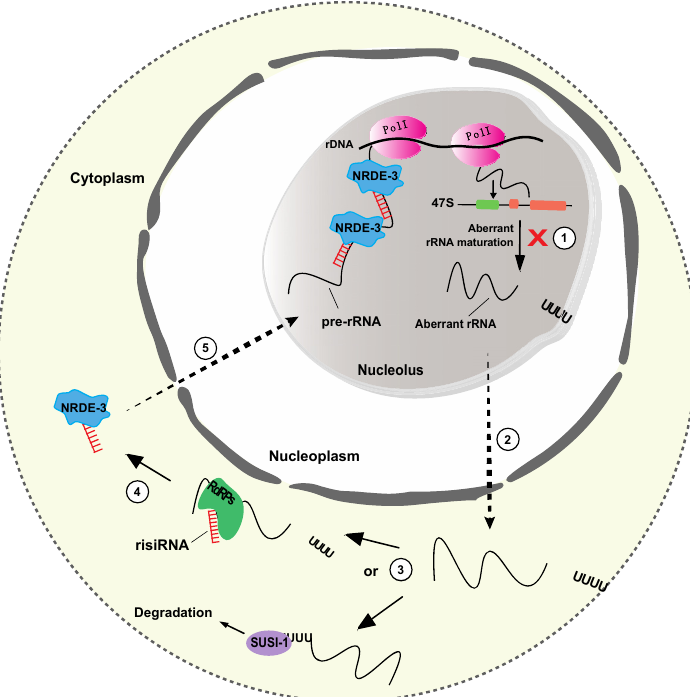
Figure 5. Biogenesis and function of risiRNAs in C. elegans . ( 1 ) In response to cellular stress or deficient rRNA modification processing, aberrant rRNAs accumulate and are uridylated at their 3 ′ end. ( 2 ) The uridylated rRNAs are, then, transferred to the cytoplasm, where they are either degraded by 3 ′ -5 ′ exoribonuclease SUSI-1 ( 3 ), or, transcribed by RNA dependent RNA polymerases (RdRPs) to produce risiRNAs (antisense ribosomal siRNAs) ( 4 ). risiRNAs can then interact with Argonaute proteins, like NRDE, and are transported to the nucleolus, where they silence the rDNA transcription ( 5 ).